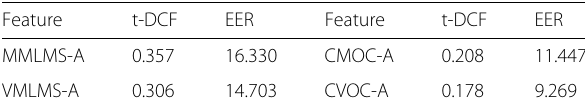
Table 12 Comparison with modified log magnitude spectrum on ASVspoof 2019 physical access evaluation set in terms of t-DCF and EER (%) Feature t-DCF EER